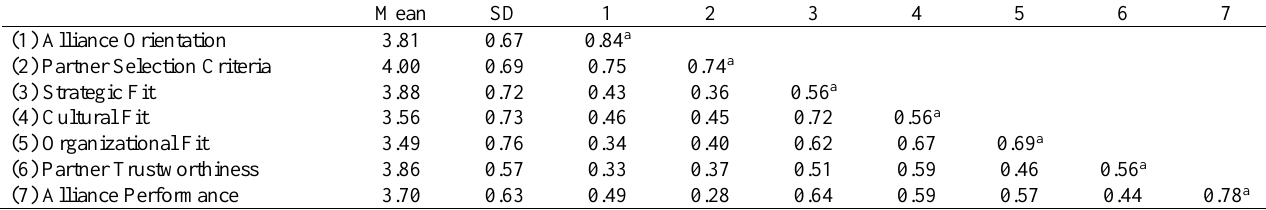
Table 3: Descriptive statistics, construct correlations and average variances extracted for the study variables